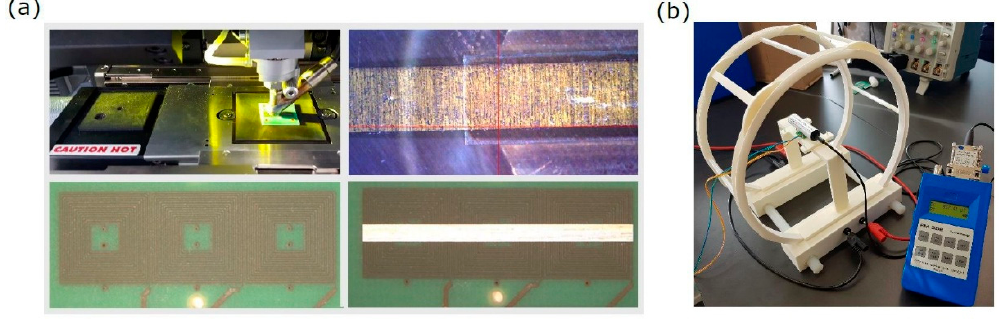
Figure 3. ( a ) Bonding procedure and sensor layout. ( b ) Experimental setup for sensor